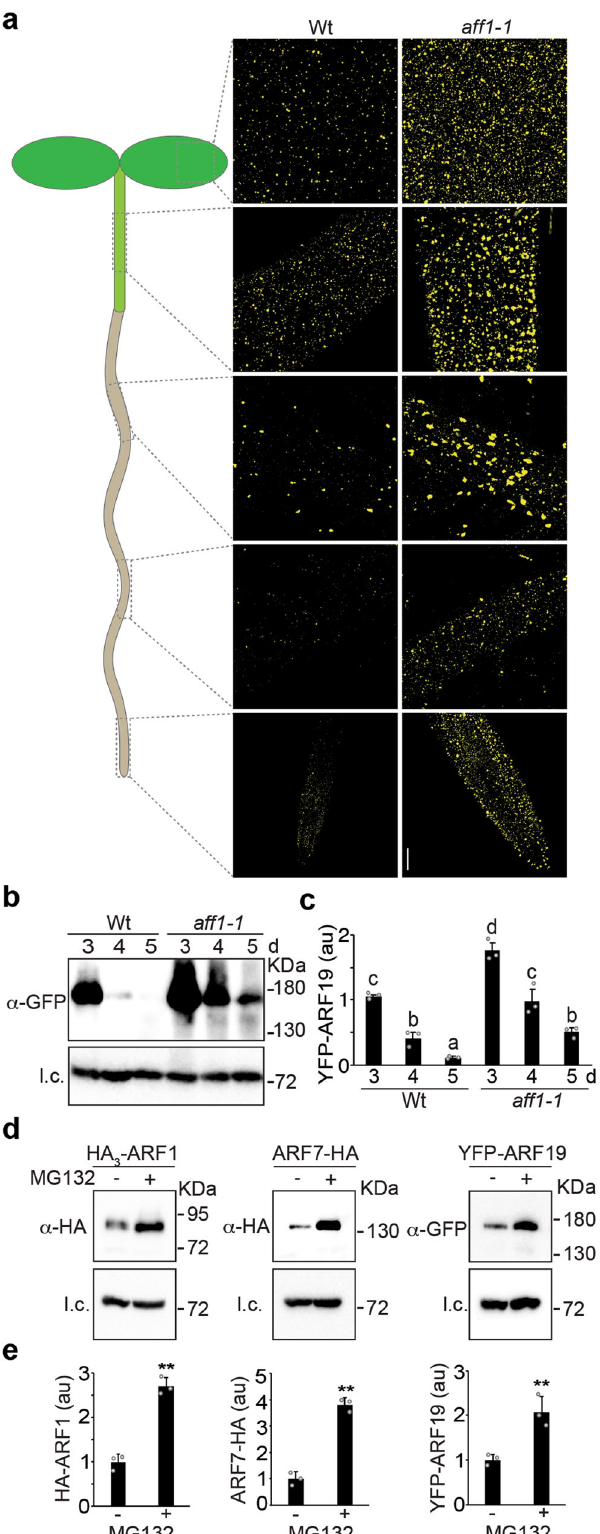
Fig. 3 AFF1 regulates ARF19 and ARF7 accumulation. a Confocal images of YFP-ARF19 fl uorescence from various tissues of 3d-old wild type (Wt; Col-0) and aff1-1 seedlings carrying 35 S:YFP-ARF19 (false-colored yellow). Three independent experiments were performed with similar results. Scale bar = 50 µ m. b Immunoblot analysis of 3d-, 4d-, or 5d-old wild type (Wt; Col-0) or aff1-1 seedlings carrying 35 S:YFP-ARF19 . Anti- GFP antibodies were used to detect YFP-ARF19, and anti-HSC70 antibodies were used to detect HSC70 (l.c.; loading control). c Quanti fi cation of YFP-ARF19 protein levels of 3d-, 4d-, or 5d-old wild type (Wt; Col-0) or aff1-1 seedlings carrying 35 S:YFP-ARF19 . Data are mean ± SD from three independent experiments and gray dots represent the individual values. Different letters indicate individual groups for multiple comparisons with signi fi cant differences (one-way ANOVA, Duncan, p < 0.05). d Immunoblot analysis of HA 3 -ARF1, ARF7-HA, and YFP-ARF19 in seedlings treated with mock (DMSO) or MG132. Anti-HA antibodies were used to detect HA 3 -ARF1, ARF7-HA, anti-GFP antibodies were used to detect YFP-ARF19, and anti- HSC70 antibodies were used to detect HSC70 (l.c.; loading control). e Quanti fi cation of HA 3 -ARF1, ARF7-HA, and YFP-ARF19 accumulation in seedlings treated with mock (DMSO) or MG132. Data are mean ± SD from three independent experiments and the gray dots represent the individual values. The statistical signi fi cance was determined by a two-sided Student ’ s t -test (Paired two sample for means). P values = 0.00043 (HA 3 -ARF1), 0.0093 (ARF7-HA), 0.0019 (YFP-ARF19). ** P < 0.01 when compared to the mock. The source data in ( b) , ( c ), ( d ) and ( e ) are provided as a Source Data fi